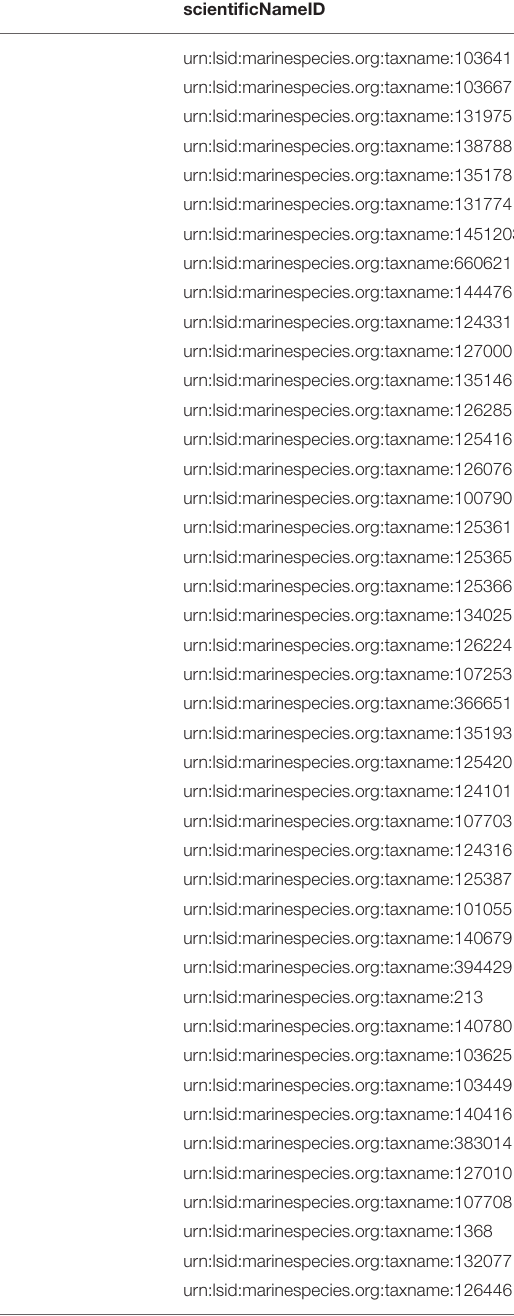
TABLE 1 | List of taxa recorded in the dataset and corresponding Life Sciences Identifier (LSID).